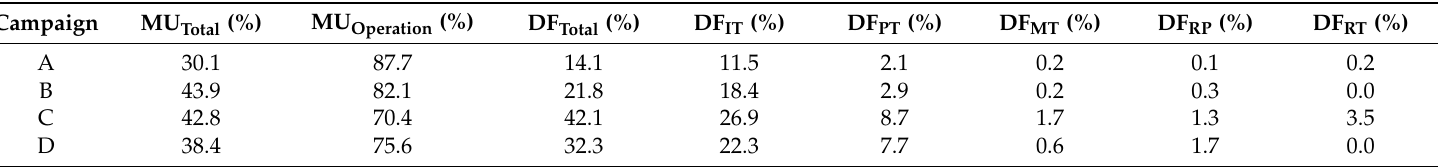
Table A2. Utilization rates of the four field campaigns in form of total on-site SSH (MU Total ), scheduled operation SSH (MU Operation ) and the MU Operetion related total delay factor (DF Total ) and delay category associated delay factors (DF IT , DF PT , DF MT , DF RP , DF RT ) in percent after Spinelli and Visser [16].